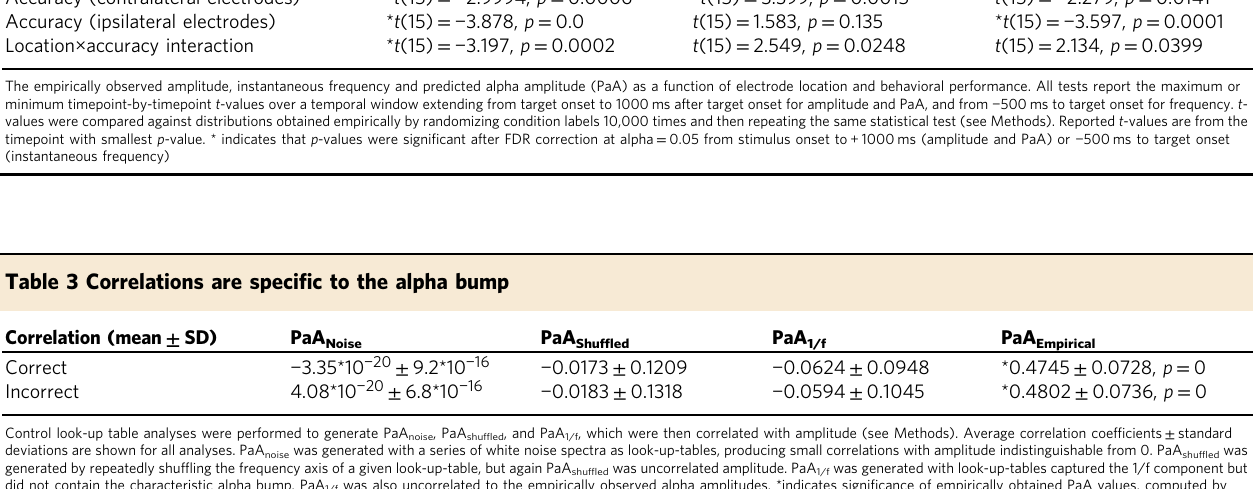
Accuracy (ipsilateral